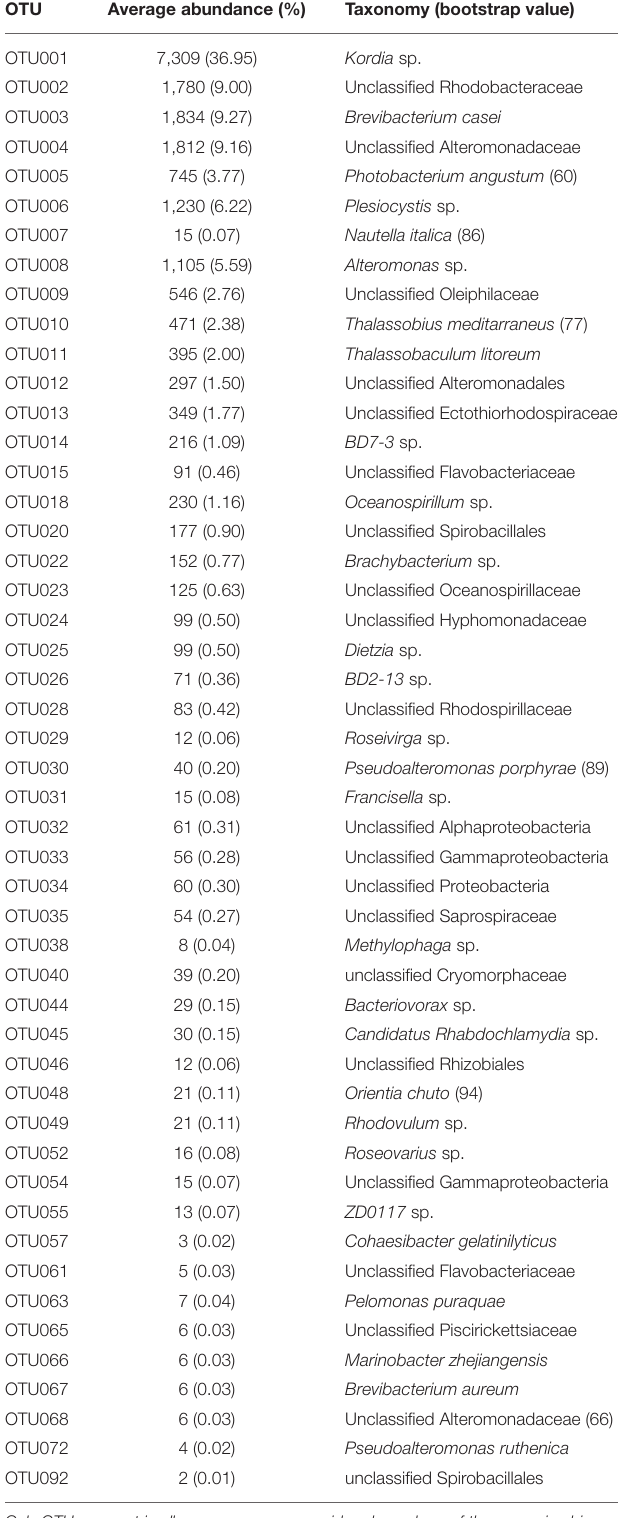
TABLE 1 | Exaiptasia H2 49 core microbial OTUs. TABLE 2 | Summary of alpha diversity indices (mean ± SD) of the microbial communities associated with Exaiptasia H2 and CC7 strains.